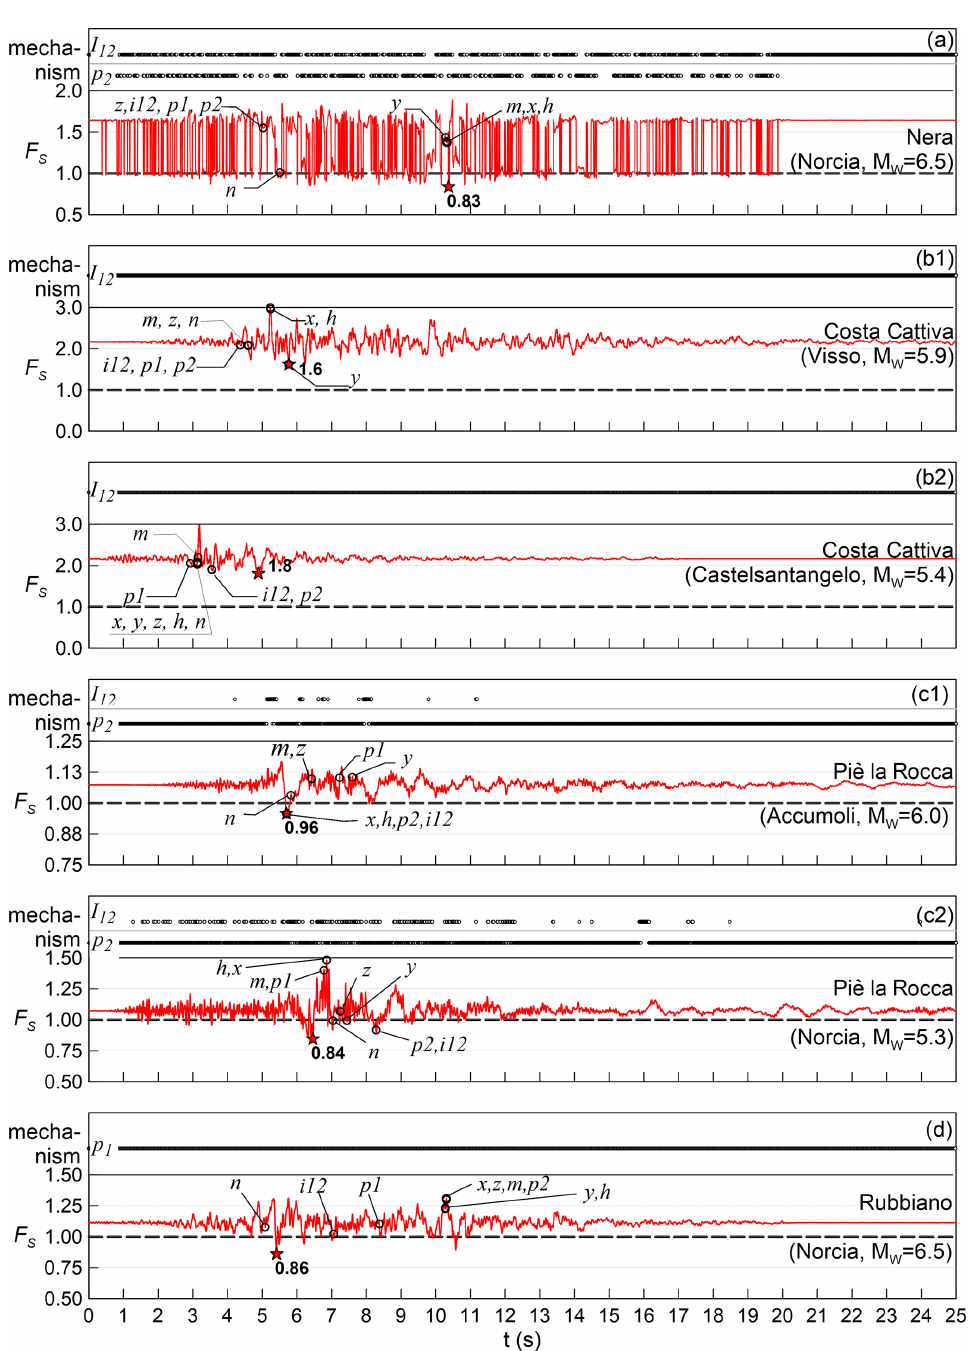
Figure 8. Time histories of the safety factor F s during the triggering shocks and of the instantaneous active mechanism: I 12 , sliding along the intersection line between the planes and p 1 and p 2 , sliding along plane 1 and 2, respectively. Stars indicate minimum F s . Empty circles highlight instants with peak values of specific acceleration components: x,y , geographic components (E, N); z , vertical component; h , horizontal component; n , component normal to the slope face; i12 , intersection line of the sliding planes; p1 and p2 , dip directions of the sliding planes; and m , instant of maximum acceleration